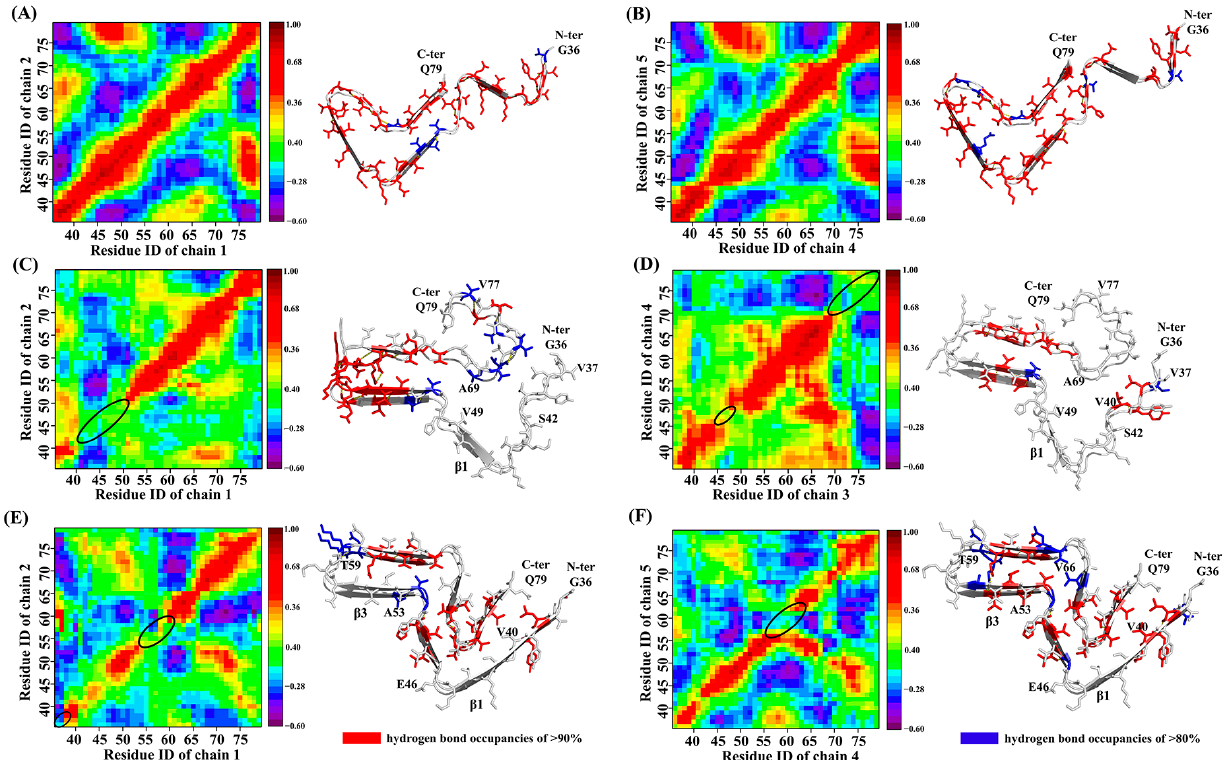
Figure 2. Analysis of DCCM (left) and backbone H-bond (right) in each system. ( A , B ) Chain-1/2 and Chain-4/5 in human brain system. ( C , D ) Chain-1/2 and Chain-3/4 in cofactor-tau system. ( E , F ) Chain-1/2 and Chain-4/5 in cofactor-free system. In DCCM analysis (left), the red region depicts a strong correlation between the residues, the blue region portrays a weak correlation and the black circles represent the possible initial dissociation sites. In H-bond analysis (right), red residues indicate the occupancy of hydrogen bond above 90%, blue residues above 80%, and white residues indicate weak H-bond interaction.